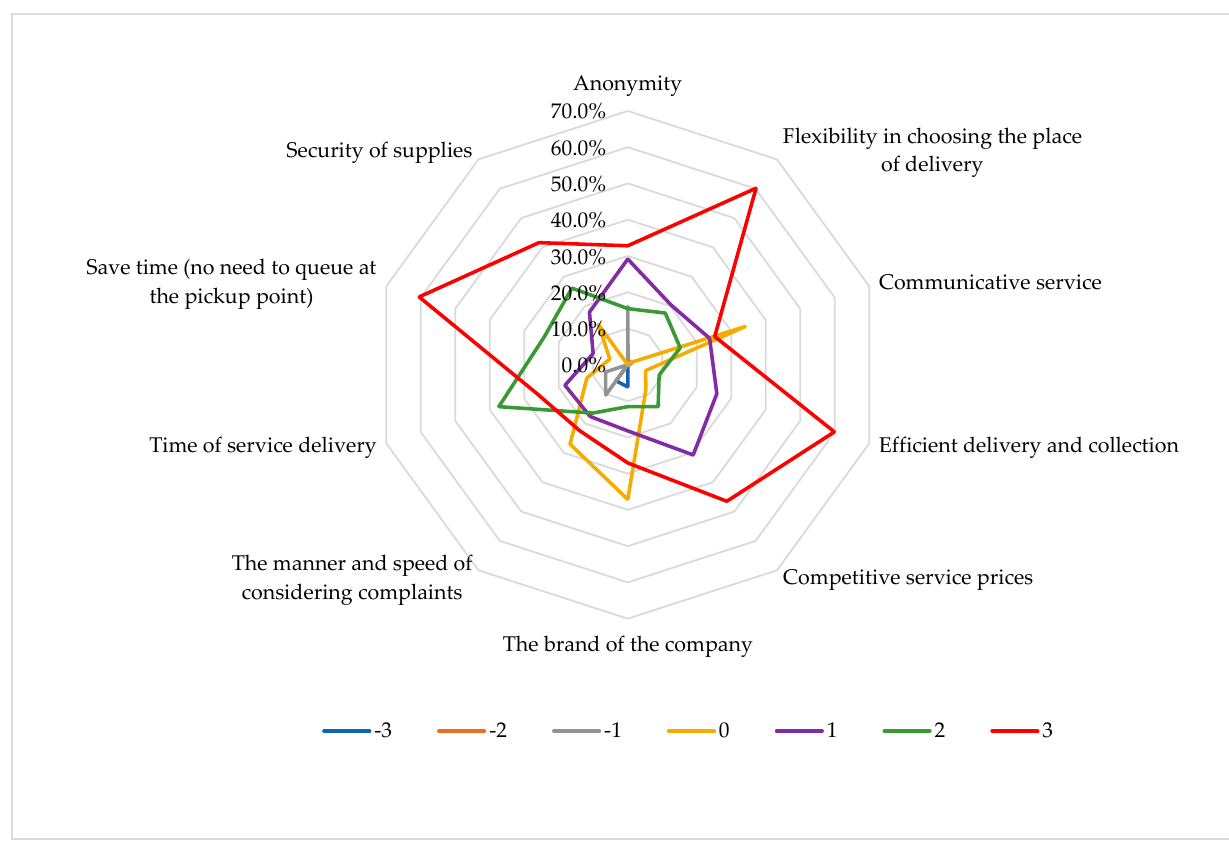
Figure 3. Assessment of the attractiveness of the parcel machines used by the respondents during the COVID-19 pandemic.